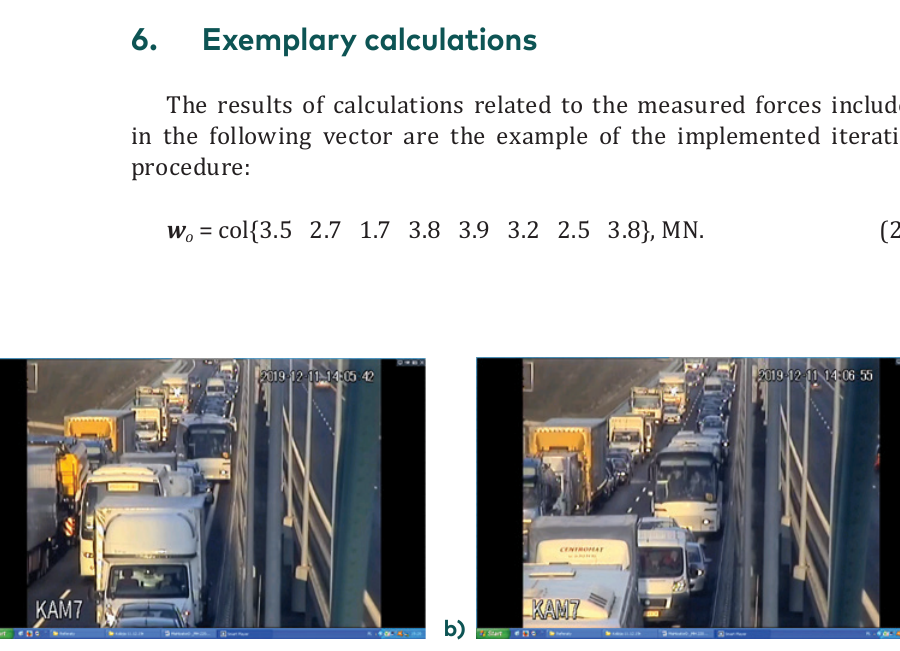
Figure 8. Traffic congestion on the bridge under